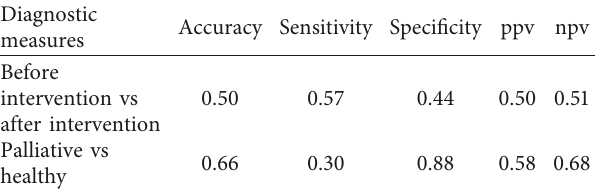
F IGURE 1: Raman spectra (with identified peaks and noise lines): (a) palliative patient (b) healthy person. Table 3: